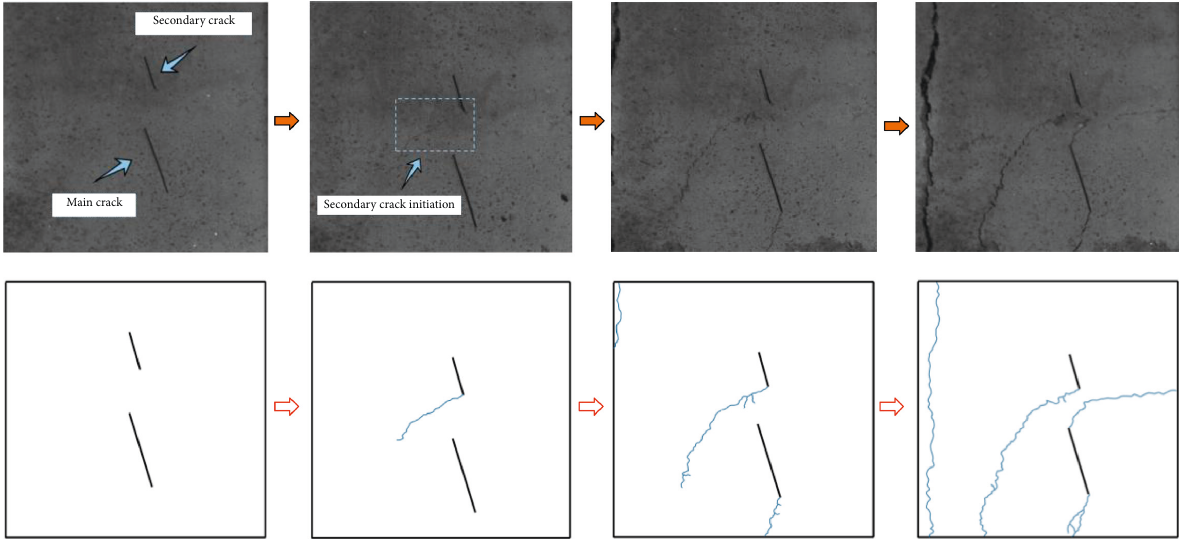
Figure 18: Crack propagation process of Specimen 6.